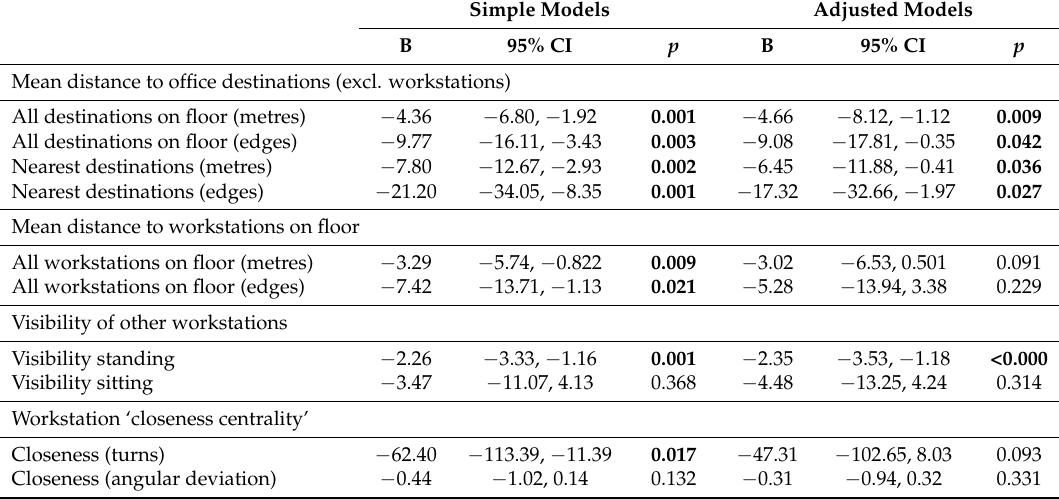
Table 3. Associations between spatial variables and workplace step count per hour. Simple Models Adjusted Models